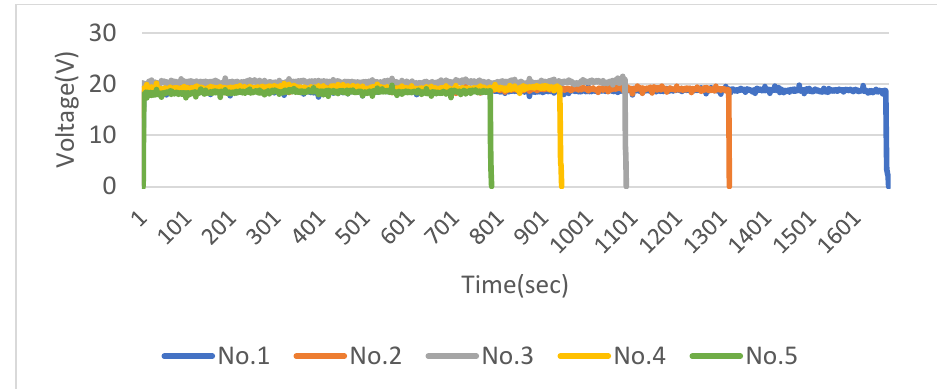
Figure 5. Voltage value of the five experiments of ECM. Heat map analysis was performed with voltage, current, and postprocessing meas- urements. The correlation between each variable was determined by assigning a score from − 1 to 1. Figure 6a presents the current versus area. A high correlation was observed between current.